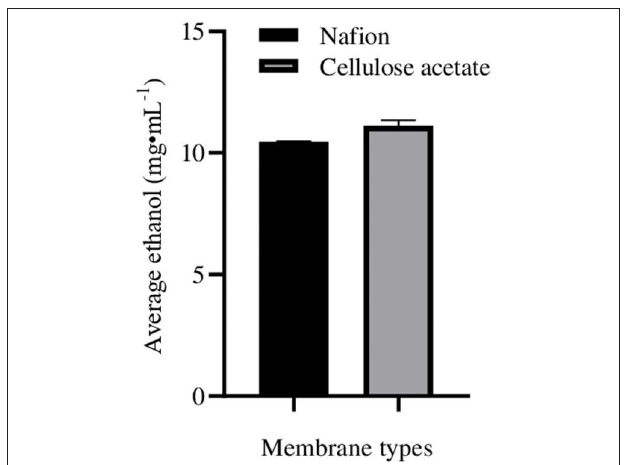
FIGURE 7 | Ethanol production from lignocellulosic hydrolysate ( S. spontaneum pretreated hot water for 2h followed by 0.5M acid hydrolysis) in ECC with CDBT2 and CDBT7 in anodic and cathodic compartments separated by nafion membrane or cellulose acetate membrane. Ethanol measurements in the cultures were determined after 3.5 days of